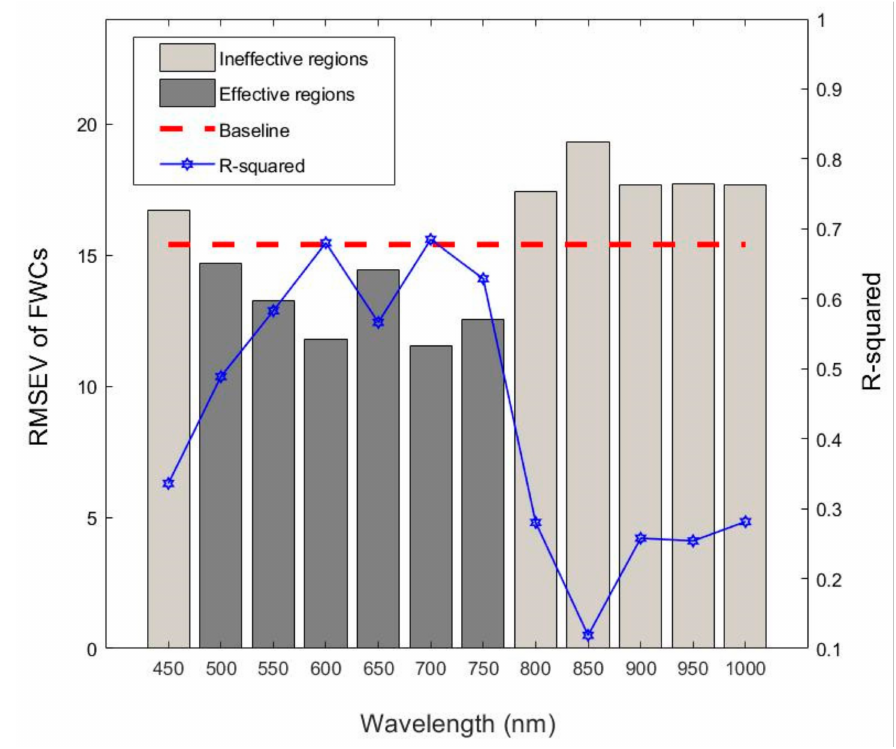
Figure 4. Selected effective wavelength region using FWC RMSEVs.